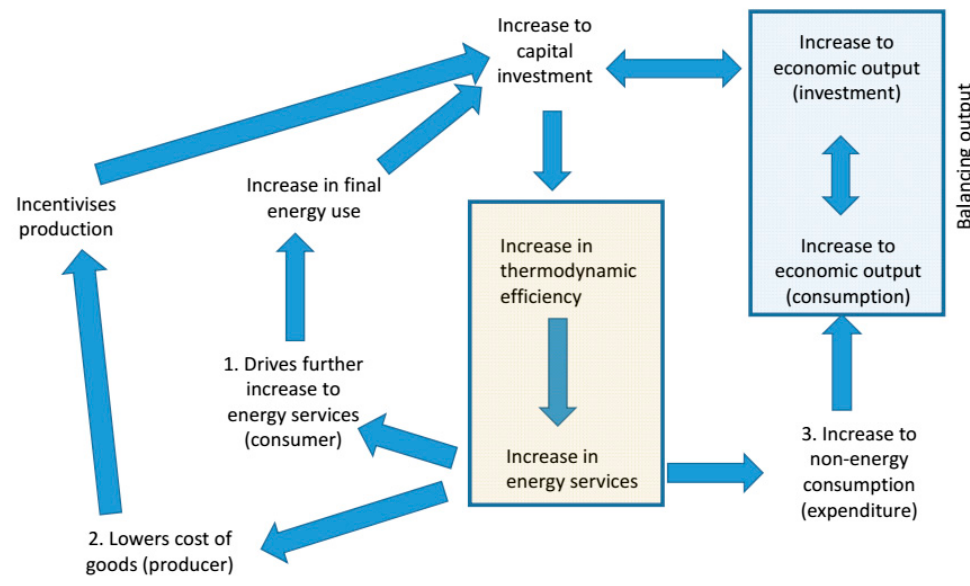
Figure 6. The ‘efficiency-led growth engine’ Figure 6 . The ‘efficiency-led growth engine’ mechanism. Figure 6 . The ‘efficiency-led growth engine’ mechanism.